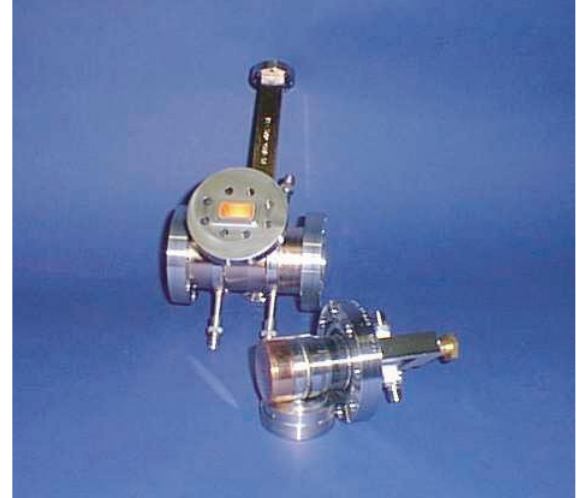
TABLE III. Cavity design parameters for the TE